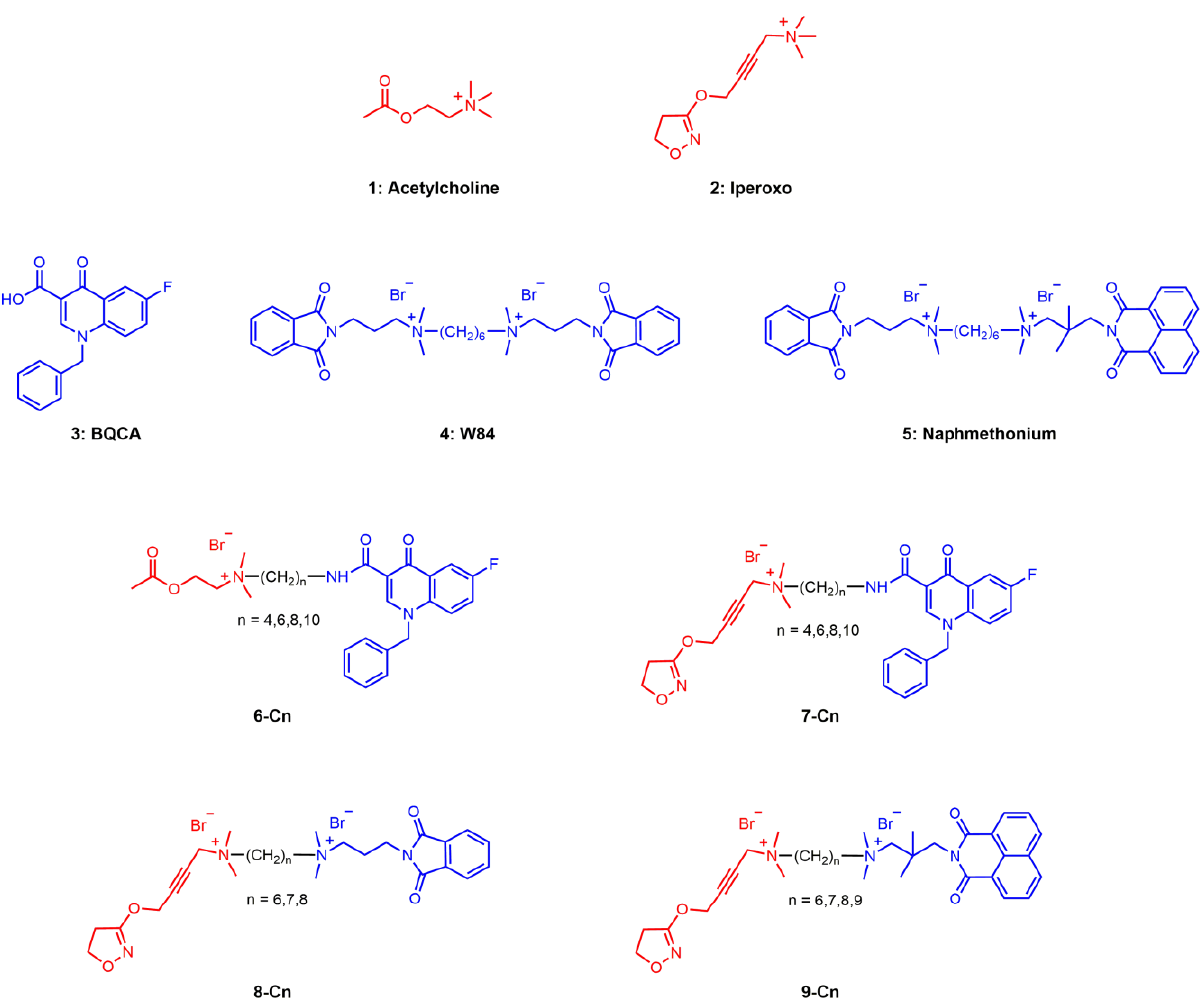
Figure 1. Structures of muscarinic orthosteric ligands ( 1 , 2 ), allosteric modulators ( 3 , 4 , 5 ), and dual- steric hybrid compounds ACh/BQCA ( 6-Cn ), Iperoxo/BQCA ( 7-Cn ), Iperoxo/W84 ( 8-Cn ), and Iperoxo/Naphmethonium ( 9-Cn ) investigated by using muscarinic FRET receptor sensors.